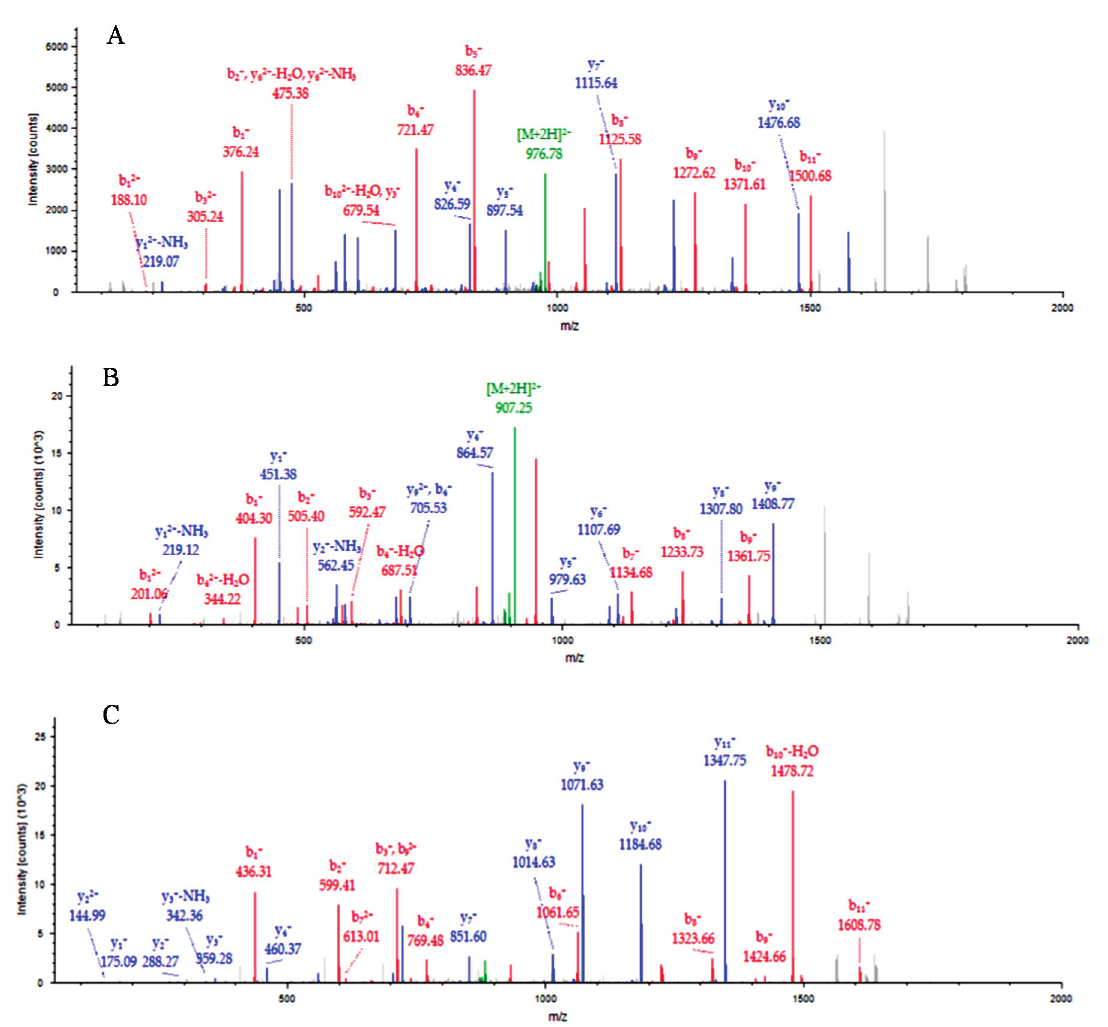
Figure 1. Peptide fragment spectral of the cell adhesion molecule-4 (CADM4) (panel A );